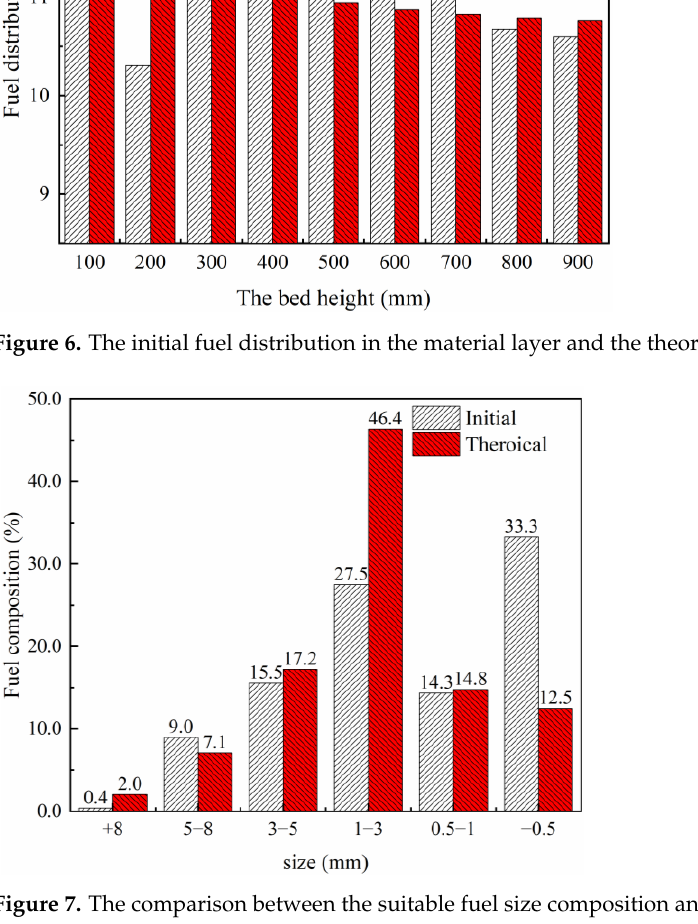
Figure 8. The particle size distribution of granules in the vertical direction of the bed.